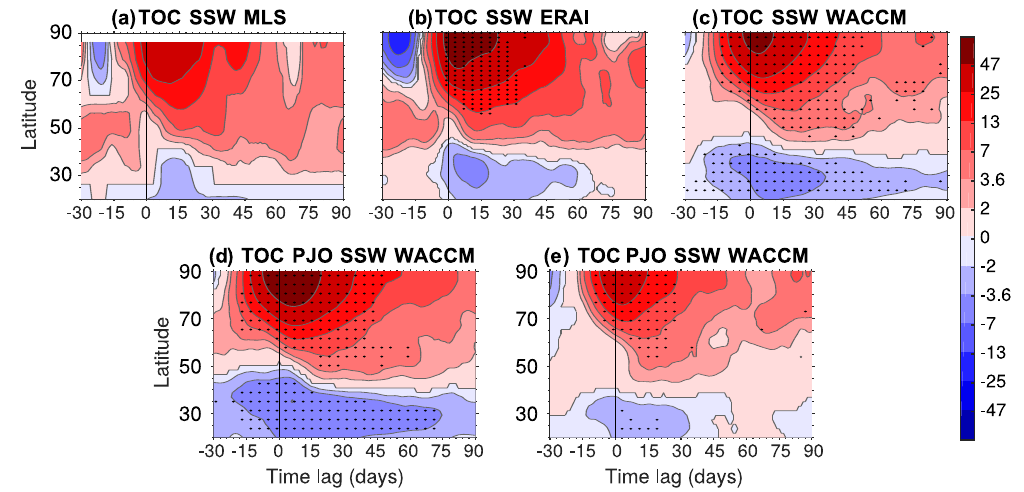
Figure 9. Composite evolution, centered on the SSW central date, of total ozone column (TOC) anomalies (DU) as a function of latitude. Composite for (a) SSWs in MLS, (b) SSWs in ERAI, (c) SSWs in WACCM, (d) PJO SSWs in WACCM, and (e) nPJO SSWs in WACCM. Black dots indicate statistically significant values (two-tailed Student’s t test, α = 0 . 01) (the statistical test has not been performed for MLS data due to the small sample of